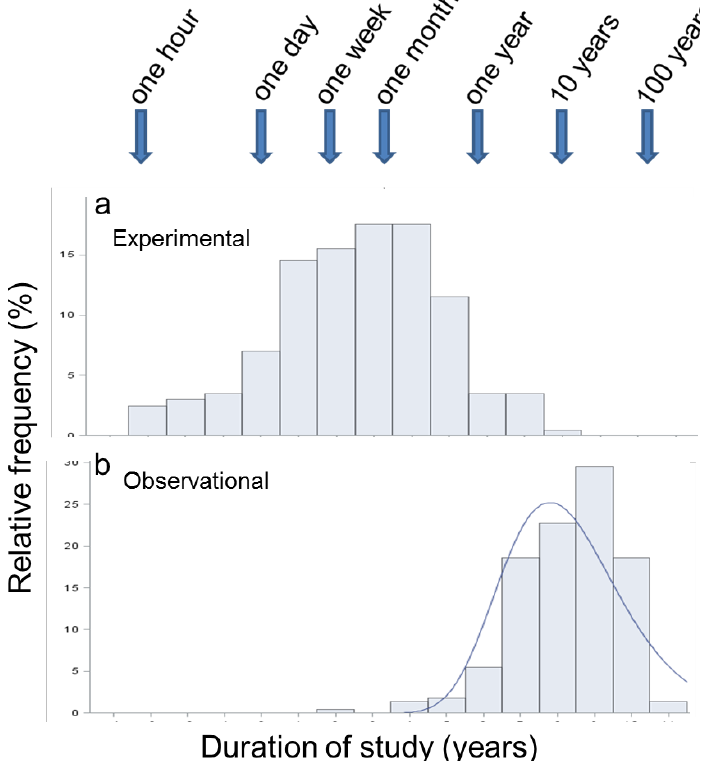
Figure 3. Frequency distribution of temporal duration of ( a ) experimental and ( b ) observational studies of climate change impacts on biodiversity in marine and freshwater environments. For observational studies based on comparisons of current with historical data, time elapsed between sampling occasions was used as a measure of study duration. Duration of study is plotted on a logarithmic scale. Figure is based on data for 207 experimental and 220 observational studies.